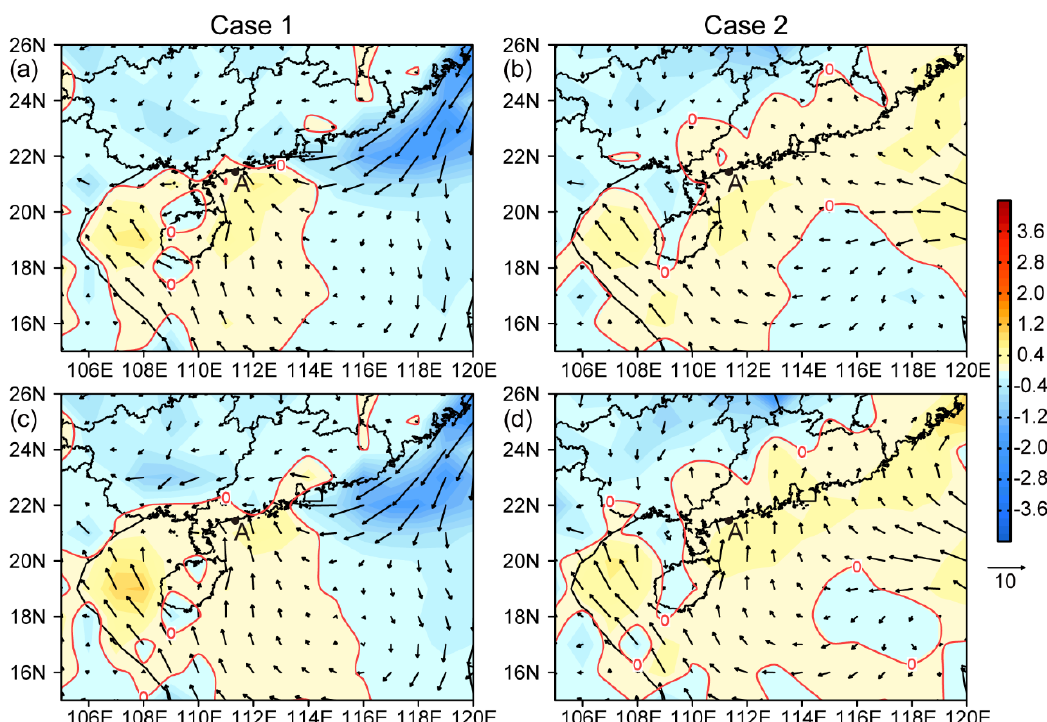
Figure 7. Time-average horizontal advection of temperature (10 − 4 K s − 1 ) and wind vectors (m s − 1 ). Left column ( a , c ) is case 1, from 2000 LST Mar 10 to 0800 LST March 11. Right column ( b , d ) is case 2, from 2000 LST Mar 30 to 0800 LST March 31. Top row ( a , b ) is at 1000 hPa. Bottom row ( c , d ) is 975 hPa. The red line is the zero line for the sign of advection. (A is the coastal site).